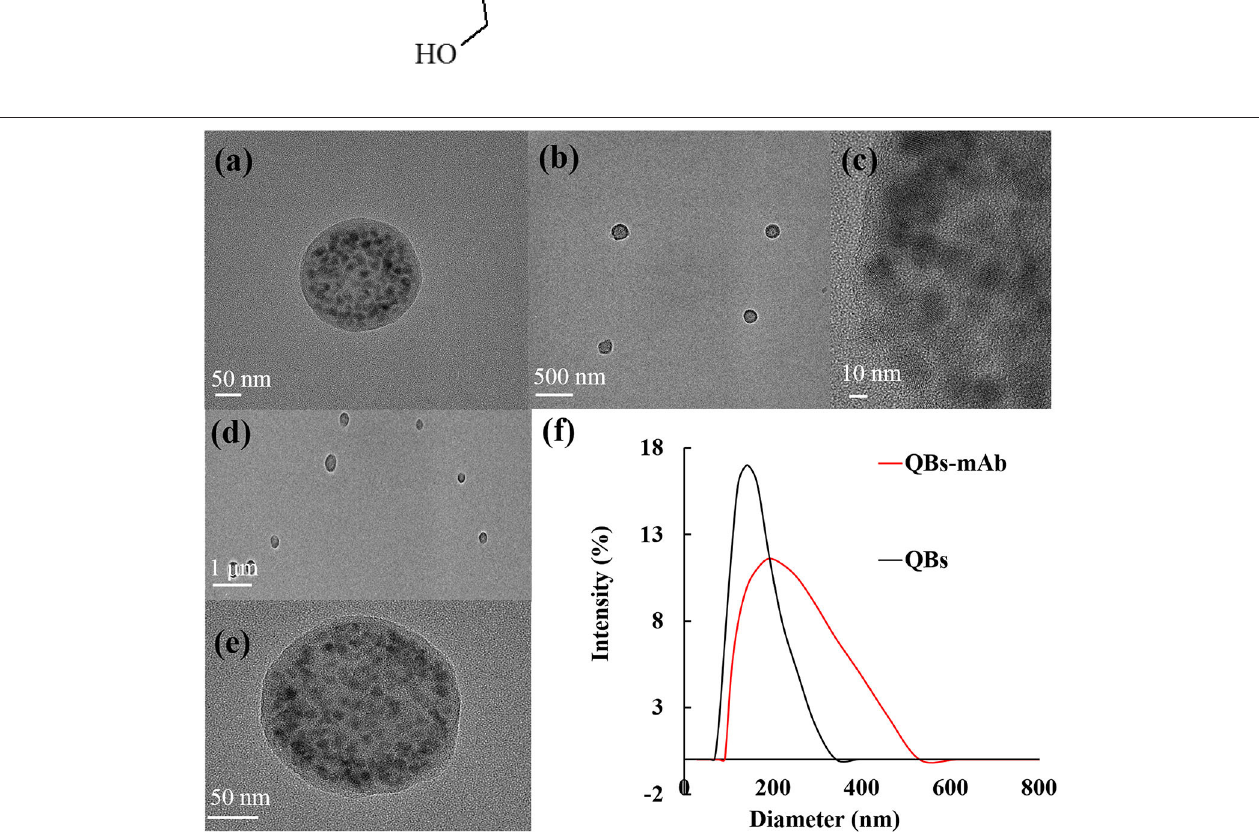
FIGURE 1 | Characterization of QBs and QBs-mAb. (a–c) : TEM image of the QBs at different magnification; (d–e) TEM image of the QBs-mAb at different magnification (f) : Hydrodynamic diameter of QBs and